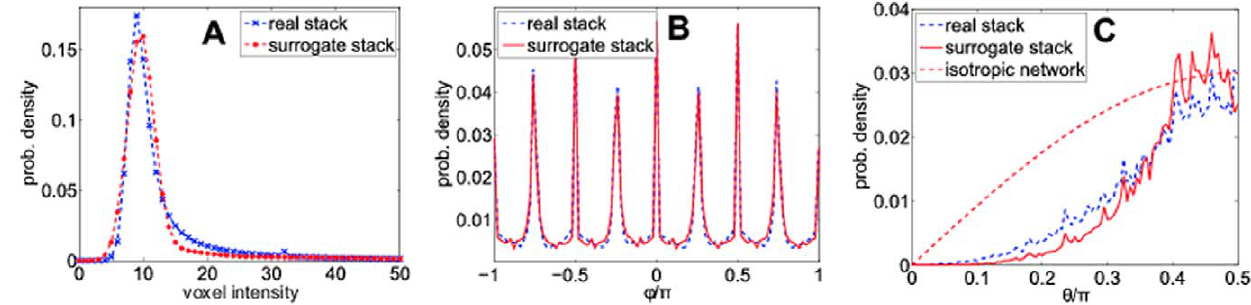
Figure 2. Statistical properties of a real and a surrogate image stacks. (A) Comparison of the voxel intensity distributions in the real and surrogate image stacks. Both distributions are similar. (B) and (C) show angular distributions of the fiber segments. (B) Typical distributions of azimuthal angles q in a real and a surrogate data set. The distributions are almost indistinguishable. The peaks are a result of voxelization. The principal directions, corresponding to the x- and y-direction, as well as the principal diagonals are over-represented in short fiber segments and lead to maxima at q ~ 0, + p , + p , + 3 p , + p : (C) Typical distributions of polar angles q in a real and a surrogate data set. Again, the distributions are similar. 4 2 4 are increasingly suppressed due to the blind spot effect of Compared to an ideal isotropic network with p ( q ) ! sin( q ) , polar angles smaller than p 2 confocal reflection microscopy [15].